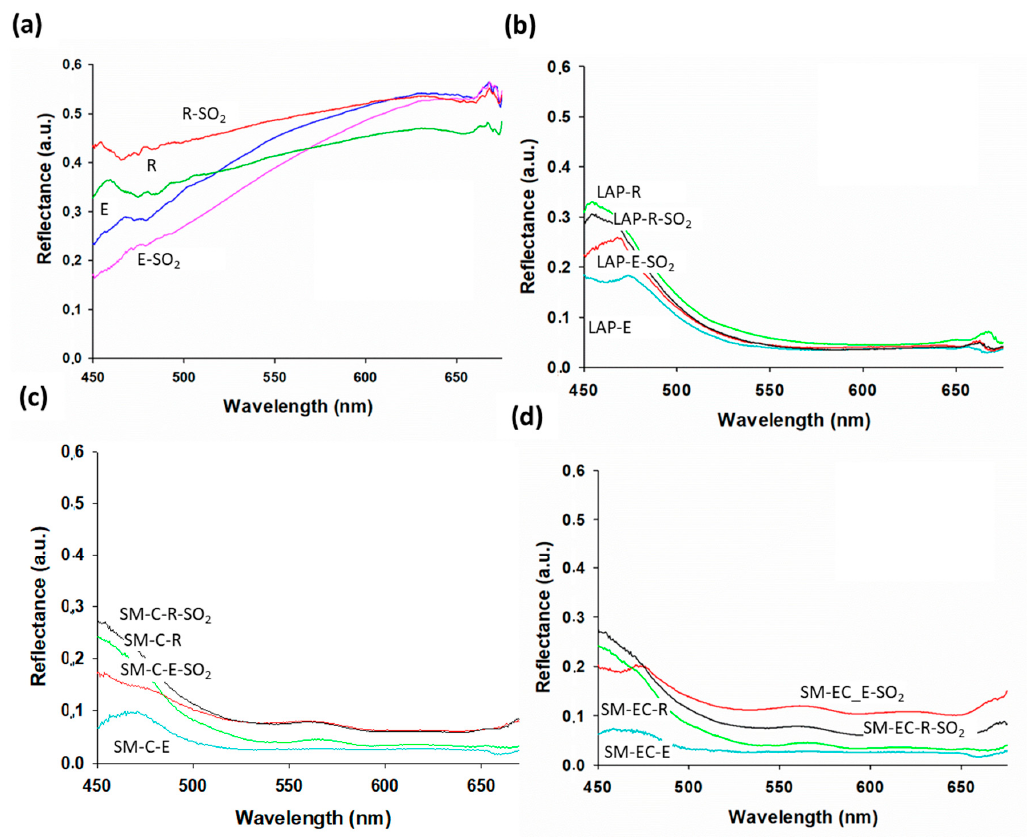
Figure 3. Reflectance spectra of the binder mock-ups ( a ), LAP-based mock-ups ( b ) and SM-based mock-ups with different grain sizes, i.e., coarse ( c ) and extra-coarse ( d ). Check Table 1 to better follow the paints labeling. –SO 2 shows the aged samples.